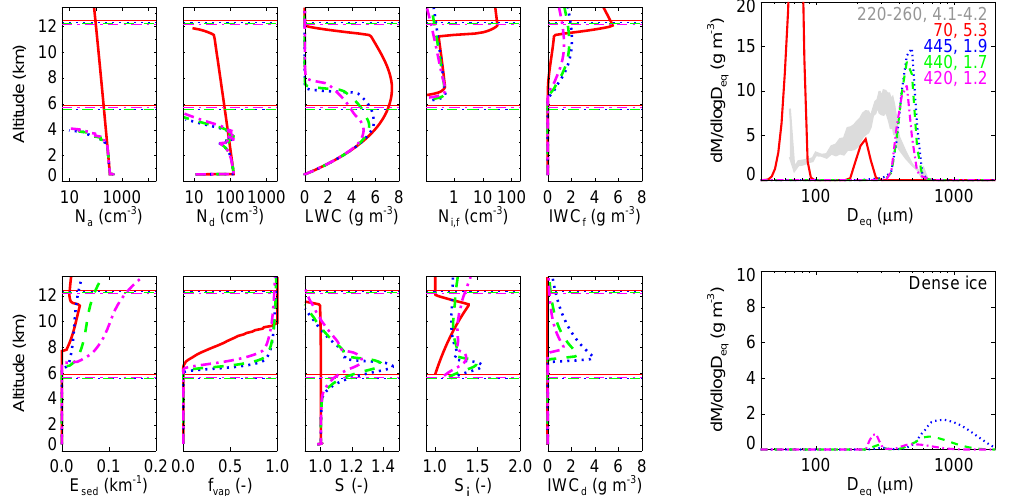
Figure 10. Top panels as in Fig. 9, except first panel is profile of total aerosol number concentration ( N a ), for simulations with baseline updraft (red solid line) and additionally allowing gravitational collection and raindrop breakup with parcel depths (cid:49)z of 2km (blue dotted line), 1km (green dashed line), and 500m (magenta dash-dotted line). Ice in top panels refers to fluffy ice class only. Bottom panels are sedimentation efficiency for fluffy ice ( E sed ), fractional hydrometeor diffusional growth occurring as vapor deposition on fluffy ice ( f vap ), saturation ratios with respect to liquid water ( S ) and ice ( S i , omitted for T > 0 ◦ C), dense ice water content (IWC d ), and dense ice PSD at − 40 ◦ C (vertical scale half that for fluffy ice). Details provided in